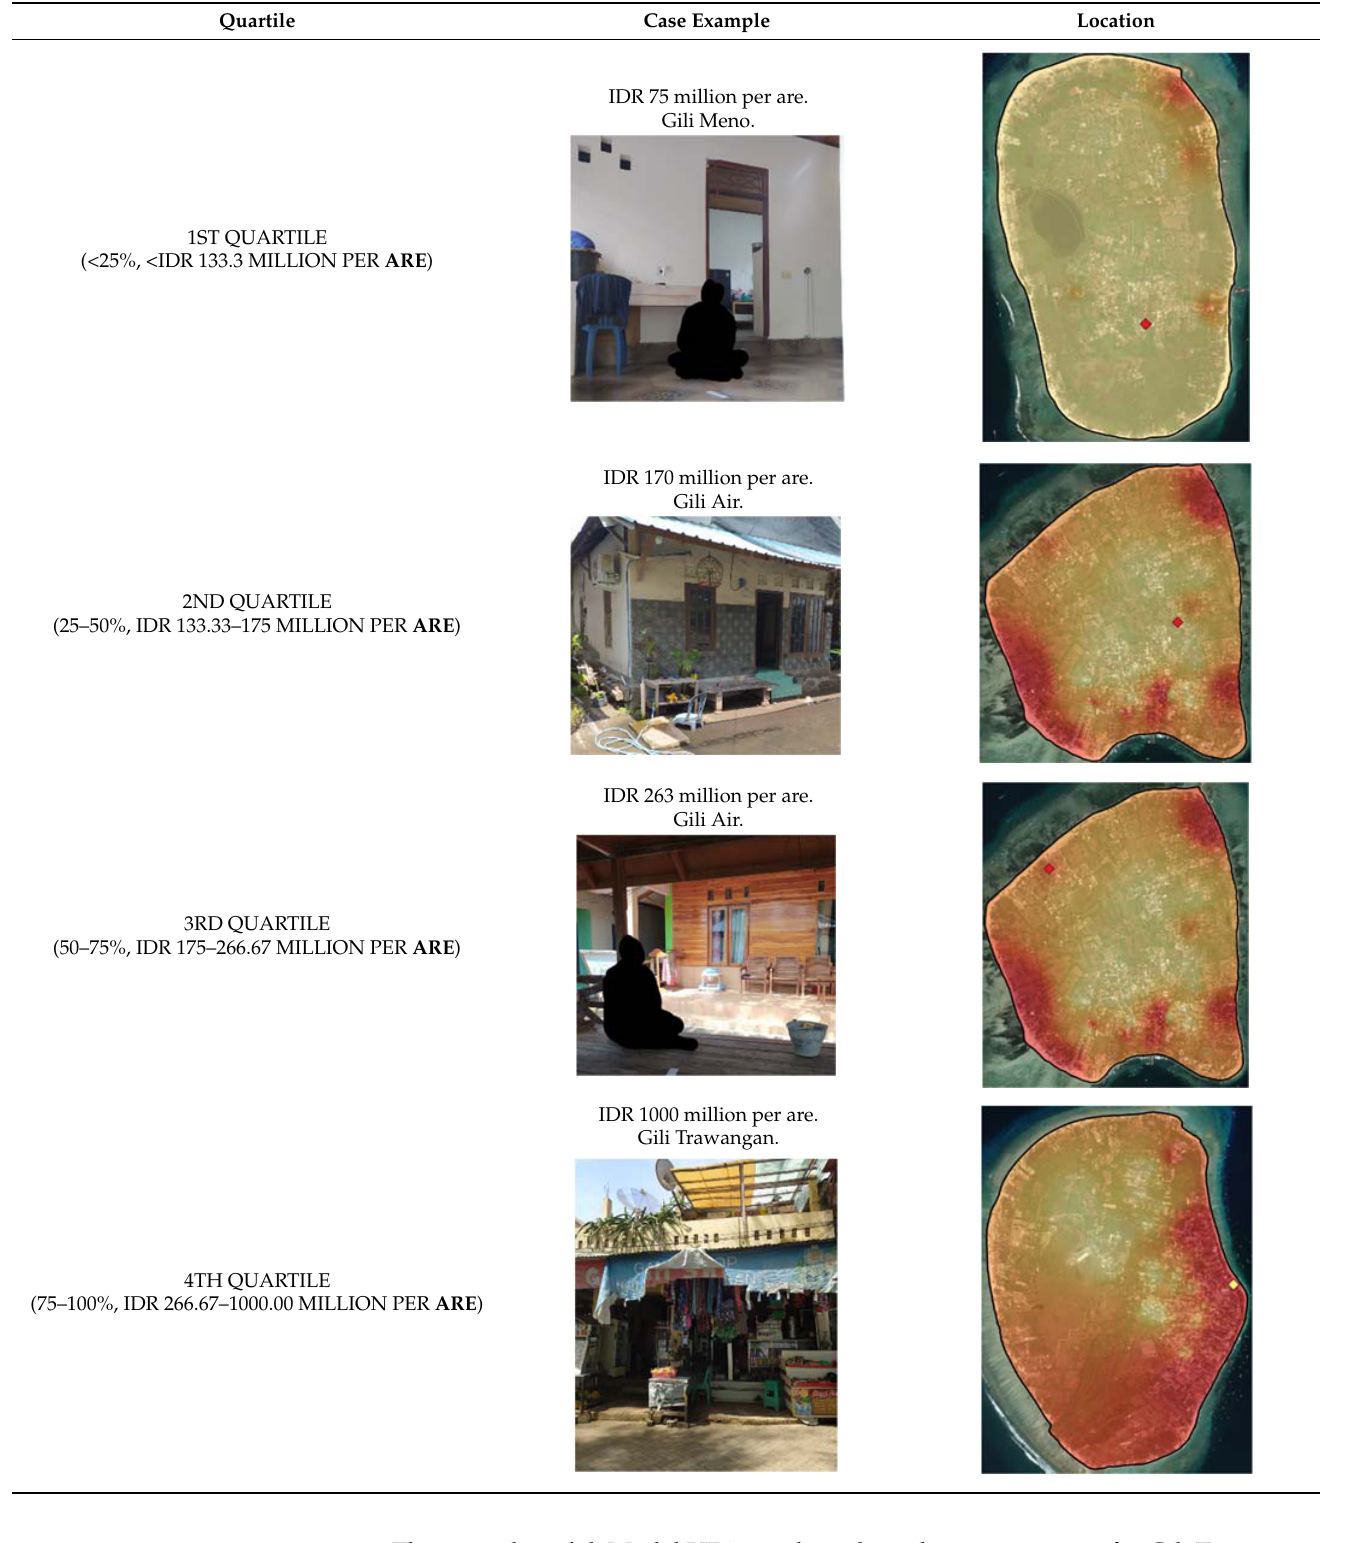
Figure 6. Interpolation of residential property prices for Gili Trawangan Island (Model